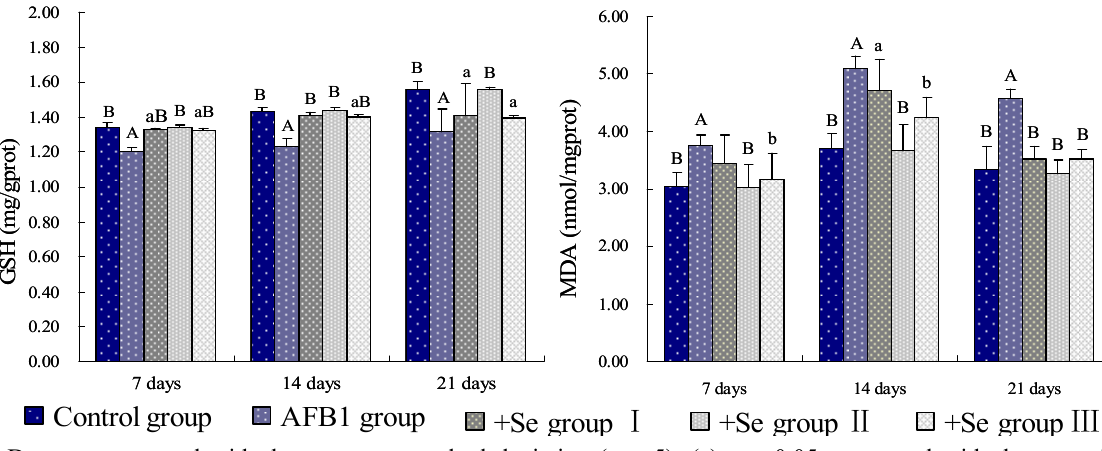
Data are presented with the means ± standard deviation (n = 5); (a) p < 0.05, compared with the control group; (A) p < 0.01, compared with the control group; (b) p < 0.05, compared with the AFB compared with the AFB group Data were analyzed by variance analysis using SPSS 16.0 1